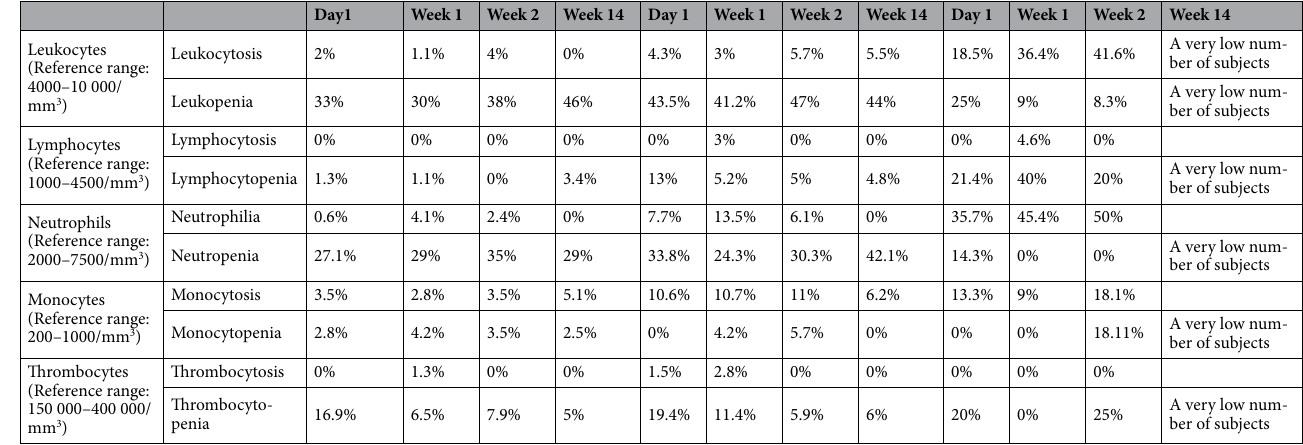
Table 3. Characteristics of differential white blood cell counts in different severity groups of